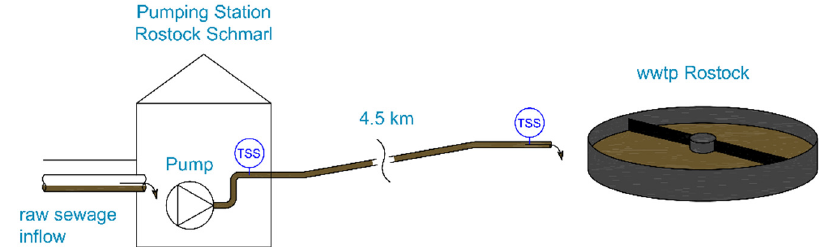
Figure 1. Schematic view of the study side. Total suspended solids (TSS) are measured inside the pressure pipe in pumping station (PS) Rostock-Schmarl and at the outflow side in the wastewater treatment plant (wwtp) Rostock after 4.5 km.